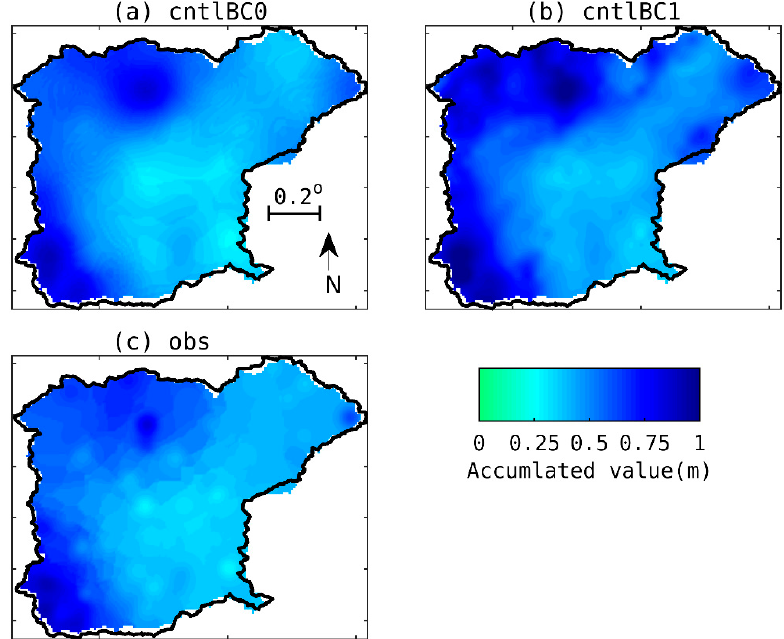
Figure A3. Accumulated distributions of the precipitation. ( a ) Linear bias correction, ( b ) statistical bias correction, and ( c ) observation.